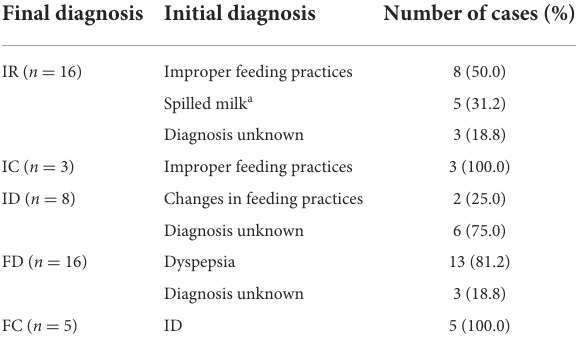
TABLE 2 The detailed data of infant FGIDs diagnosis modification rate. TABLE 3 Prevalence of common functional gastrointestinal disorders in infants aged from 1 to 12 months